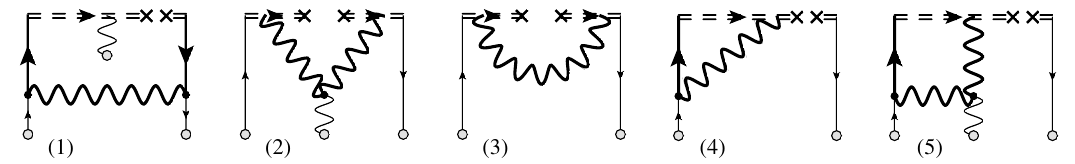
Figure 2 . Example of diagrams that vanish in our scheme of calculation. Diagrams (1) and (2) vanish due to A + = 0. Diagram (3) is proportional to 1 (cid:0) (cid:11) and vanish at (cid:11) = 1. Diagrams (4) and (5) vanish since the dimensionally regularized loop integral does not have a scale. The bold lines denote the propagators of quantum (cid:12)elds. The thin lines with bubbles are background (cid:12)elds. The double dashed lines are Wilson lines and crosses show that they are pointing to light cone